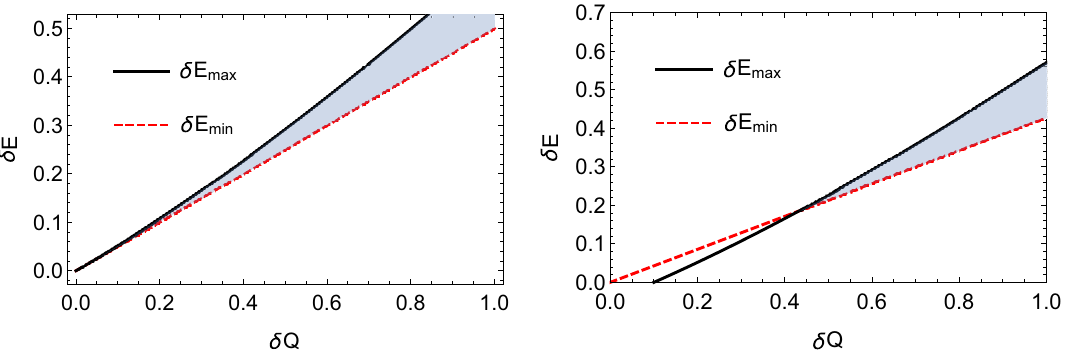
Gauss–Bonnet coupling constant α = 3, and a charge of the extremal black hole Q = 1, b charge of the near-extremal black hole Q = 0 . 9. The grey region is for δ E max > δ E